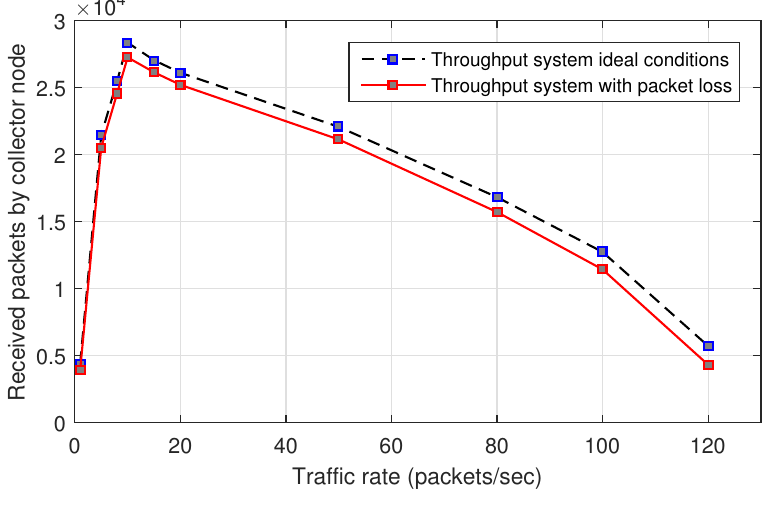
Figure 14. System throughput.